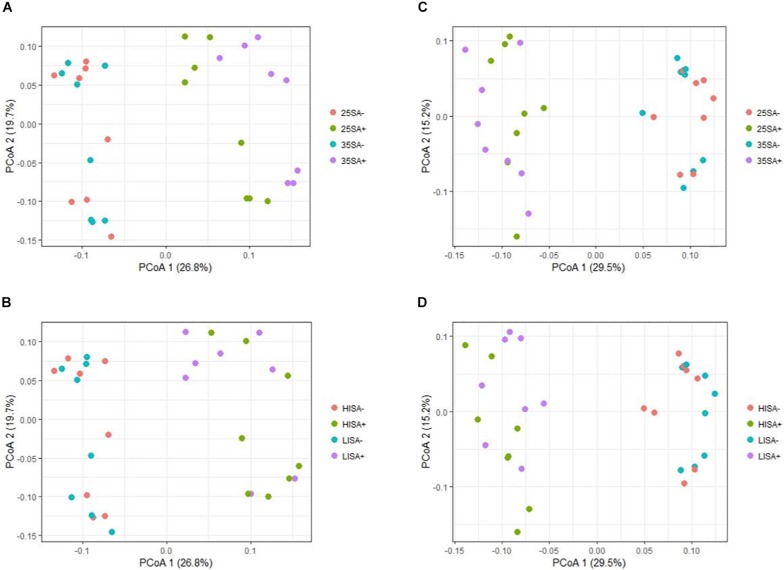
Changes in prokaryotic community composition associated with the interactions of different pre-ensiling treatments at the late time point, visualized as a principal co-ordinate analysis (PCoA) using weighted UniFrac distance metrics for (A) treatments dry matter (DM) concentration × sucrose addition in liquid phase samples; (B) wilting intensity × sucrose addition in liquid phase samples; (C) DM concentration × sucrose addition in solid phase samples; (D) and wilting intensity × sucrose addition in solid phase samples. Abbreviations indicate the interactions of treatments including different dry matter concentrations (25 or 35), wilting intensities [low (LI) or high (HI)] and sucrose addition [with (SA+) or without (SA−)]. The percentage of variation explained is indicated on the respective axes.